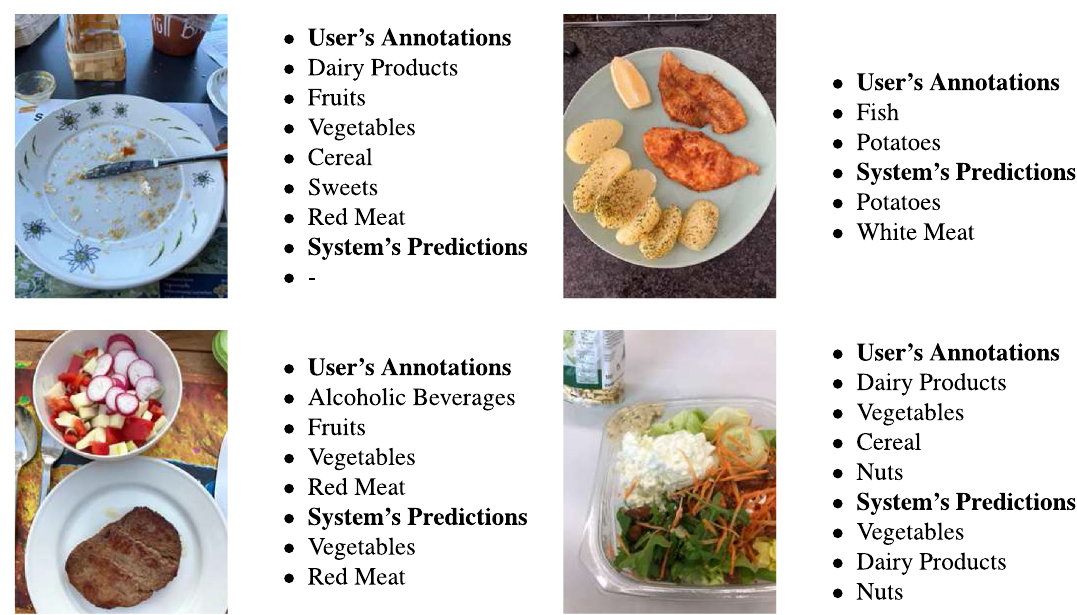
Figure 5. Images acquired from the feasibility study, along with the users’